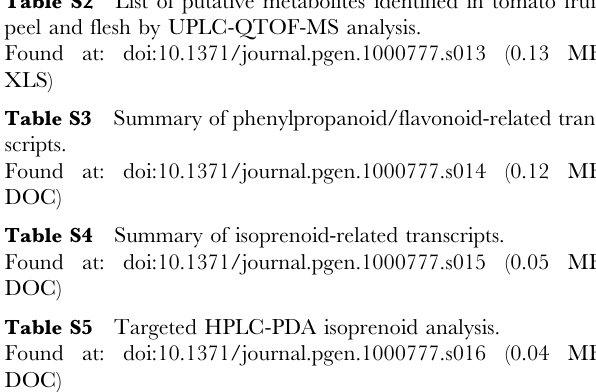
compared to those of their corresponding wt. Black numbers indicate metabolites that did not differ between the y mutant and its corresponding cv. AC wt. Figure S11 RT-PCR relative transcript expression analyses of SlTHM27 (previously described by Mintz-Oron et al. [9], SlMYB4- like and SlMYB12-like in wt peel and flesh during five stages of fruit development. Table S1 All transcripts identified by the microarray analysis as differentially expressed between the y mutant and wt fruit tissues. Table S2 List of putative metabolites identified in tomato fruit peel and flesh by UPLC-QTOF-MS analysis. Table S3 Summary of phenylpropanoid/flavonoid-related tran- scripts. Table S4 Summary of isoprenoid-related transcripts. Table S5 Targeted HPLC-PDA isoprenoid